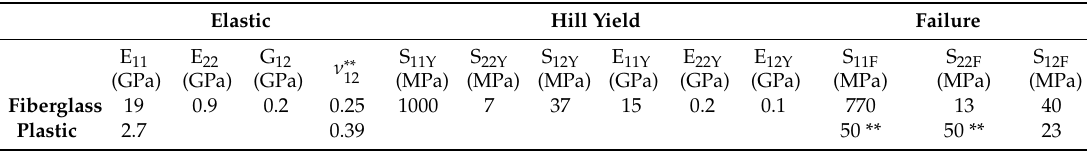
Table 6. Material properties used in the finite element (FE) model.